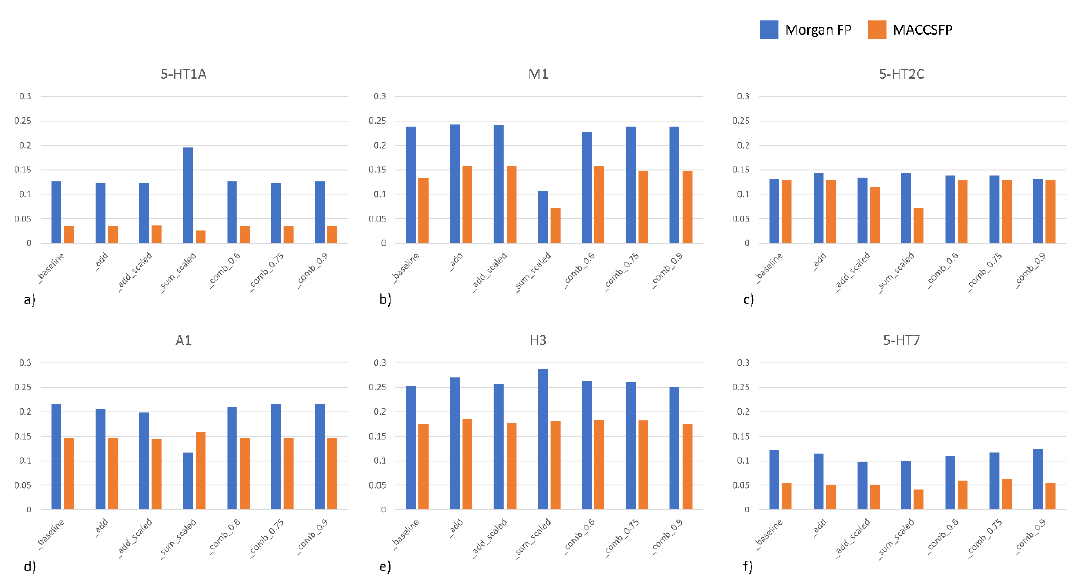
Figure 4. Precision at top 10% for various ranking strategies for selected targets. ( a ) 5-HT 1A ; ( b ) M 1 ; ( c ) 5-HT 2C ; ( d ) A 1 ; ( e ) H 3 ; ( f ) 5-HT 7 .